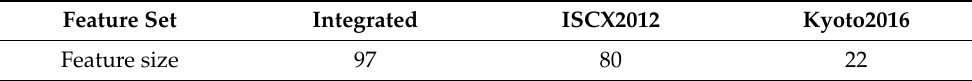
Table 5. Feature set size .